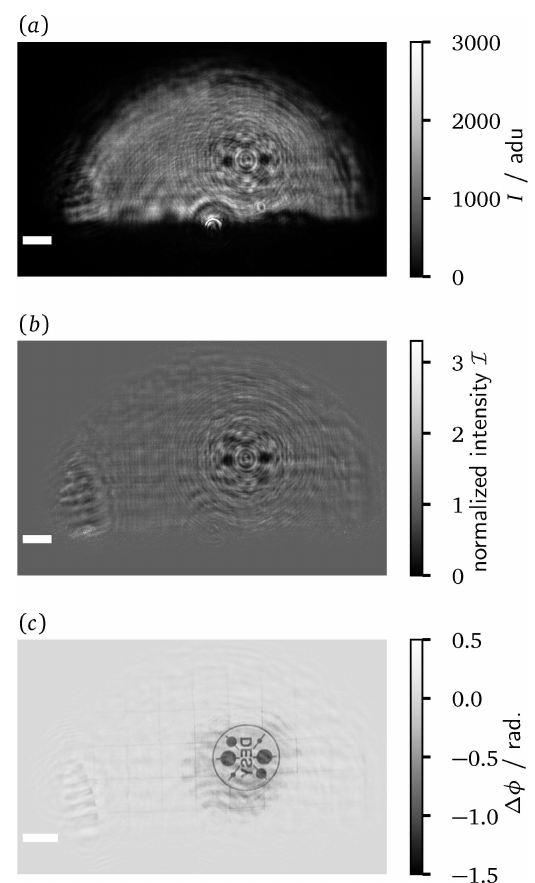
Figure 5 Overview of the data evaluation for PBPCI. ( a ) Dark frame corrected raw data for a sample measurement in analog digital units (adu) of the sCMOS camera. ( b ) Normalized intensity, obtained by the empty beam division. ( c ) Phase reconstruction obtained with the RAAR scheme from ( b ). The scale bar indicates 1 mm length in the detection plane for panels ( a ) and ( b ) and 10 m m in the sample plane for ( c